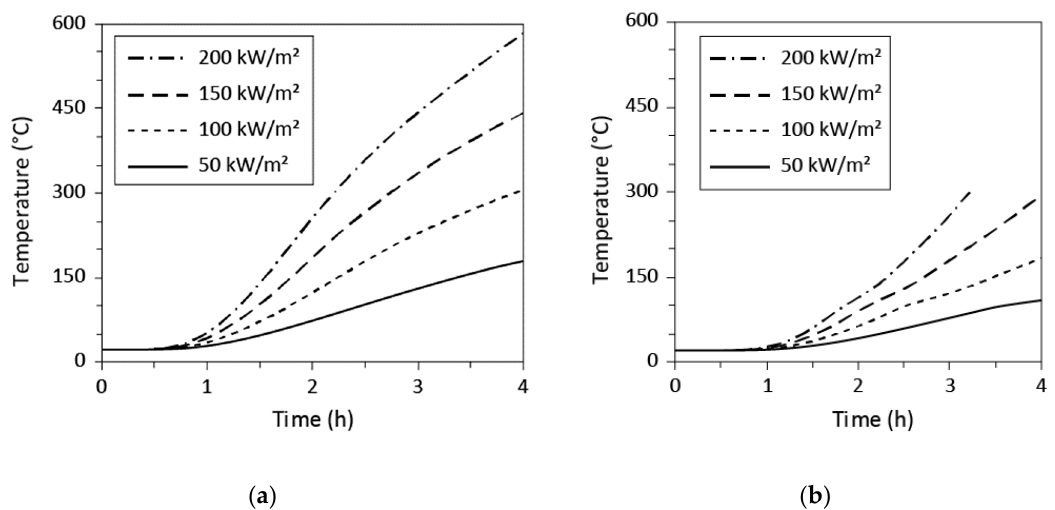
Figure 14. ( a ) Temperature evolution at the depth of 10 cm of a substrate layer within the green roof assembly installed on a wooden deck with no gypsum board; ( b ) temperature evolution at the top of the wooden deck.